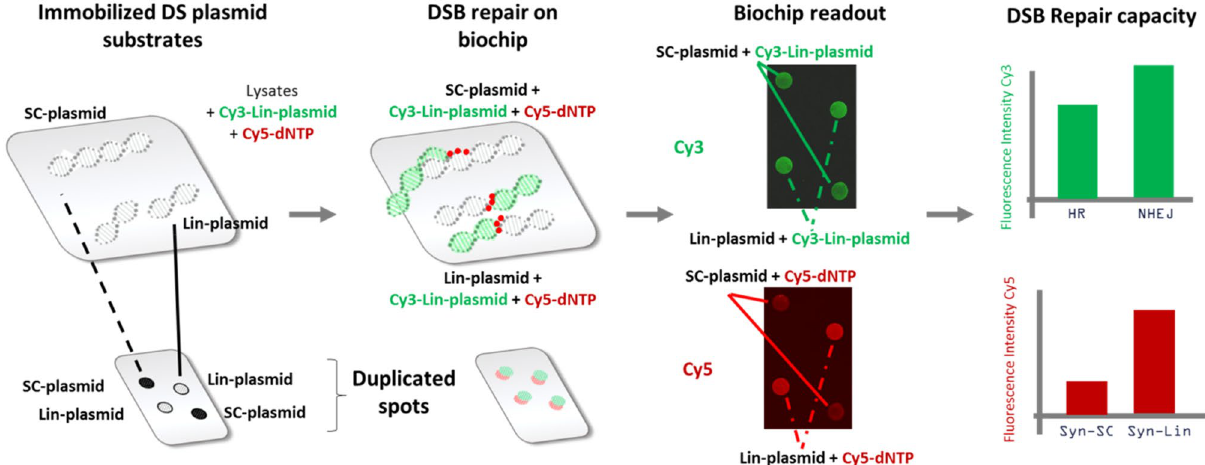
Figure 1. Overview of the principle of the NEXT-SPOT assay on biochip. Each biochip is composed of 14 pads, each pad contains two spots of two immobilized substrates: supercoiled plasmids (SC-plasmid) and linear plasmid (Lin-plasmid). Repair reactions occur on the support between the immobilized substrates and the Cy3- labelled linear plasmid (Cy3-Lin-plasmid), the biotin-dCTP, and the cell lysates added to each pad. Then, the biotin-labeled dCTP is revealed by Cy5-streptavidin. Alternatively Cy5-dCTP can be used. Signals are quantified using a dual-color laser-induced fluorescence scanner (excitation wavelengths: 532 and 635 nm). SC-plasmid supercoiled plasmid, Lin-plasmid linearized plasmid, Syn-SC DNA synthesis on SC-plasmid, Syn-Li : DNA synthesis on